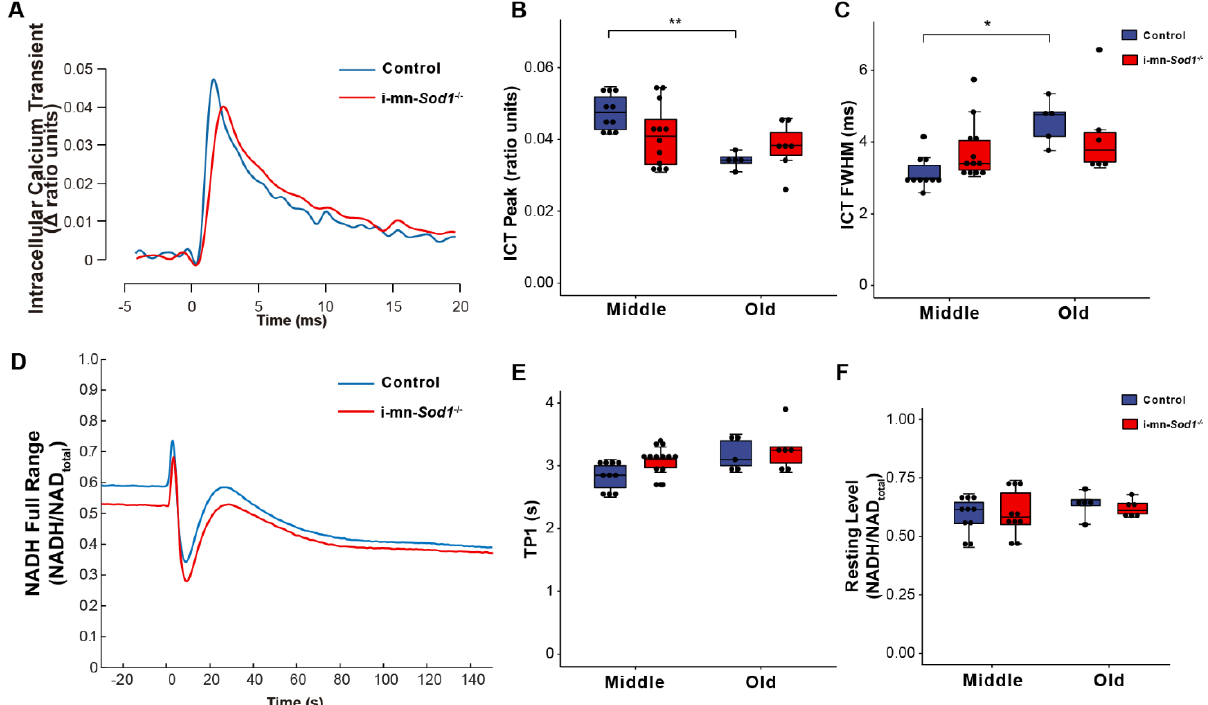
Figure 5. Comparison of calcium handling and mitochondrial function between control and i-mn- Sod1 -/- mice. Representative traces are shown for ( A ) intracellular calcium transients (ICT) and ( D ) NADH fluorescence response to a tetanic contraction for lumbrical muscles of control (blue) and i-mn- Sod1 -/- (red) mice at middle-age. Data are shown for ( B ) the peak of the intracellular calcium transient (ICT peak), ( C ) time during which the ICT remains at or above its half maximum width (full width at half-maximum, ICT FWHM), ( E ) time for NADH fluorescence increase to the 1 st peak with contraction, and ( F ) basal NADH level prior to contraction for control (blue; n=10 for middle age, n=5 for old age, blue) and i-mn- Sod1 -/- (red; n = 12 for middle age, n = 7 for old age) mice. Data in B , C , E , and F are presented as individual data points with box plots and error bars indicating the minimum, first quartile, median, third quartile, and maximum number of the dataset. Data were analyzed by two-way ANOVA, * p < 0.05, ** p < 0.01.